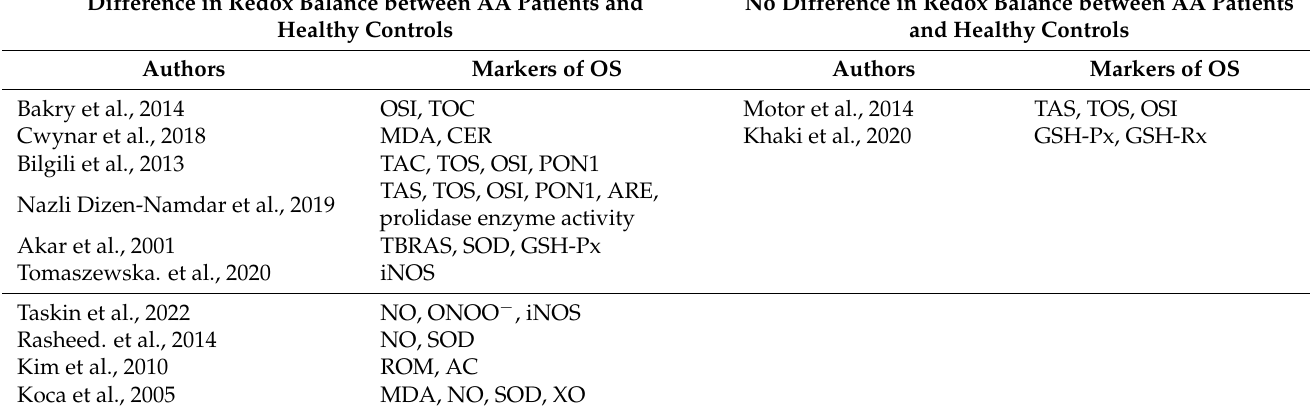
Table 2. Summary of the works dividing them into those in which a difference in the redox balance between the AA patients and the controls was found and those in which no difference was found. The majority of the studies found an imbalance of redox